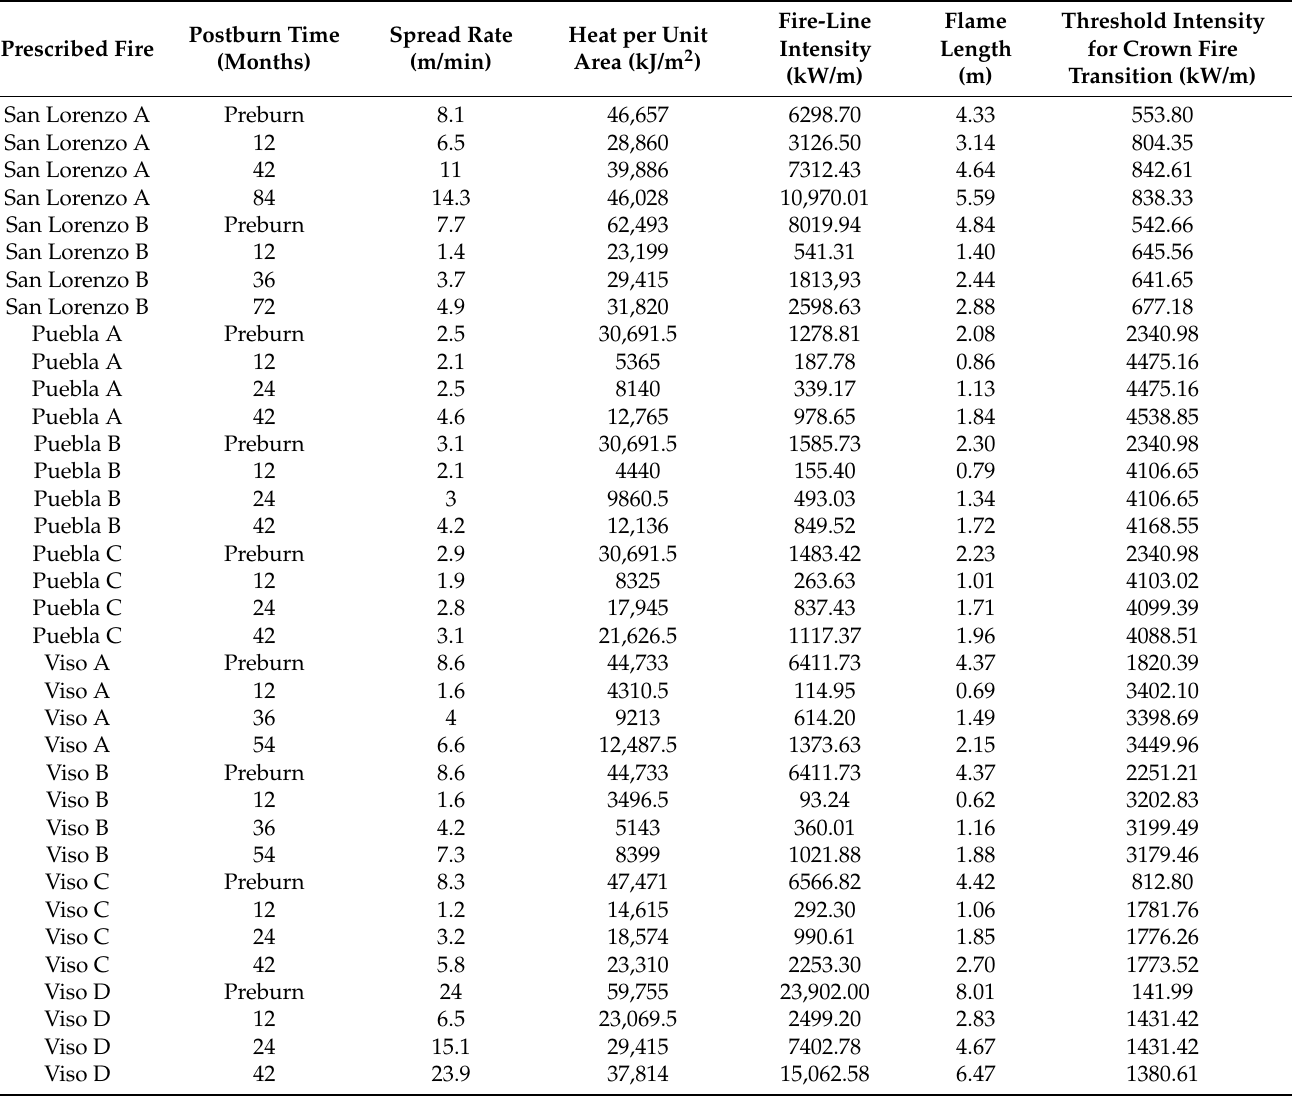
Table A2. Estimation of fire behavior parameters based on weather scenarios and periodical vegetation dynamics.